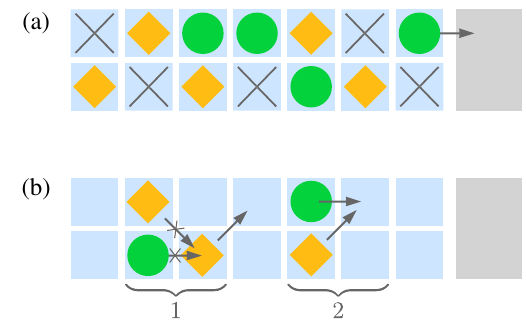
FIG. 3. Illustration of topological hindrance for a system with W ¼ 2 lanes at the right lattice end. (a) State where the motion of each particle in the bulk is blocked (jammed state) and only the rightmost particle is allowed to move (arrow). Empty lattice sites (crosses) are present, which lead to average densities below the full occupation for jammed systems. (b) The second species, which changes the connectivity of the network of possible particle motions, amplifying the impact of steric hindrance in our model. Bracketed area 1 shows how a single particle can now block up to two other particles. Area 2 shows how particles might align such that motion has to occur sequentially. The same symbols as in Fig. 1 are used to illustrate the system and particles.